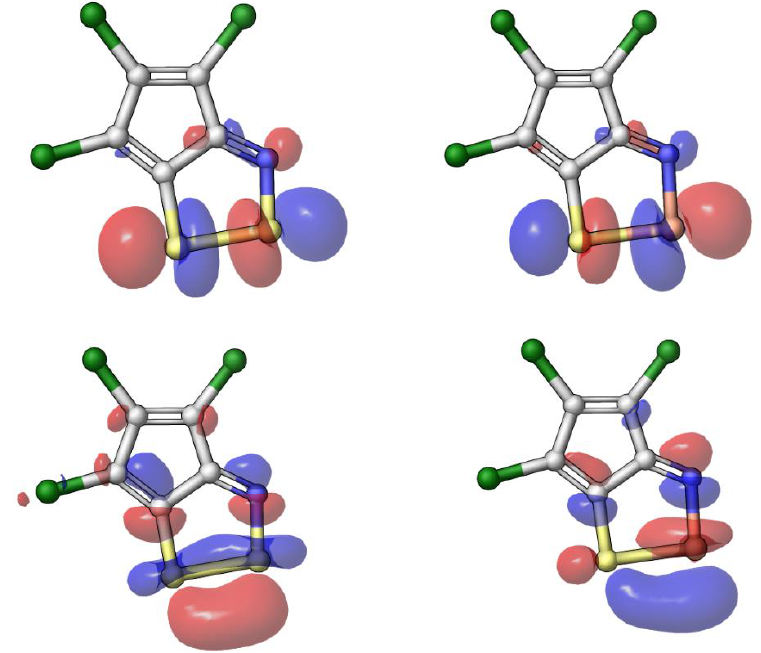
Figure 3. Upper row shows LUMO+1, which suggest directions of the potential scissile bond. Lower row shows empty LUMO+2 orbital, which are thought to be available for nucleophilic attack by negatively charged highly nucleophilic cysteine. The atoms are colored: yellow - sulfur; bronze - selenium; blue - nitrogen; grey - carbon; green - chlorine.